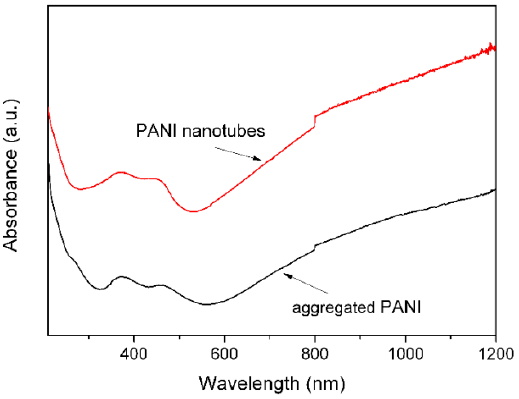
Figure 4. UV-Vis-NIR spectra of PANI nanotubes and aggregated PANI.